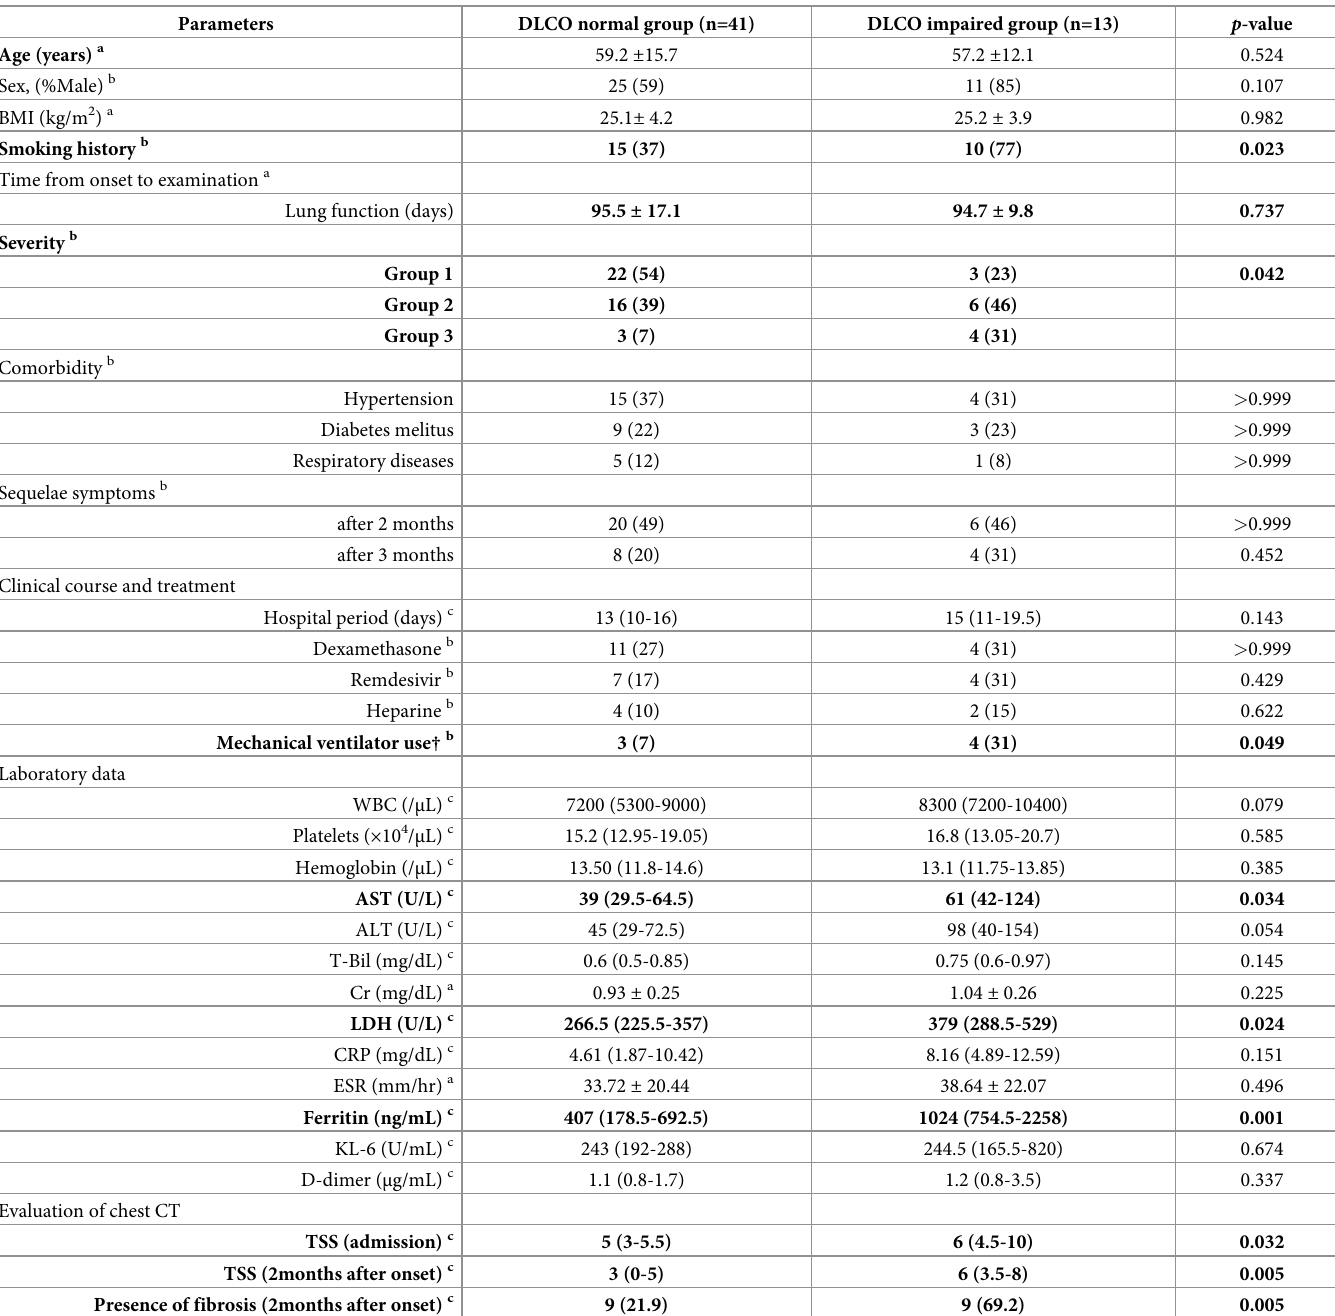
Table 2. Characteristics of patients in the DLCO normal group and DLCO-impaired group 3 months after